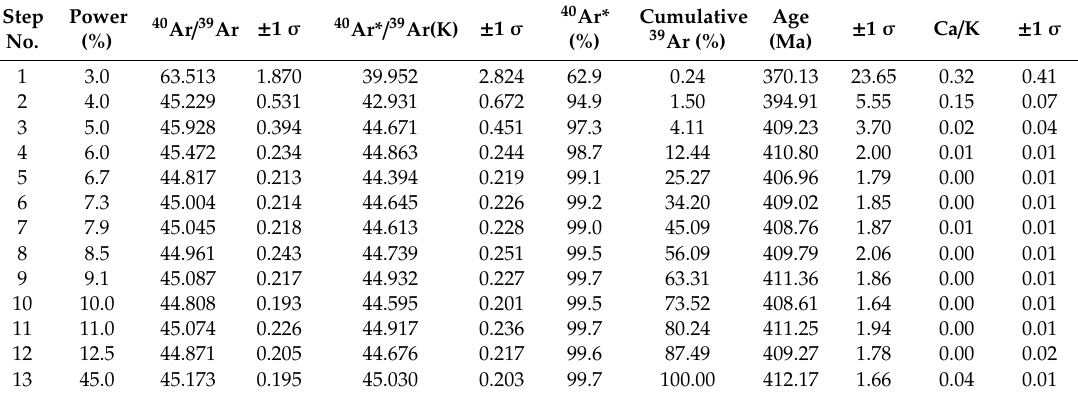
Table 7. Argon step heating data of muscovite from sample LG-80-33-1848, J value = 0.005696 ±